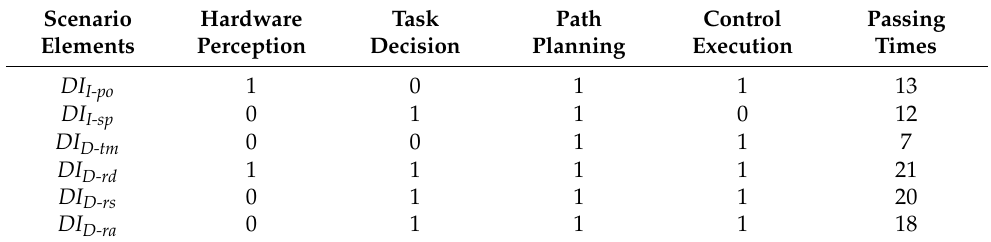
Table 6. The passing times of the